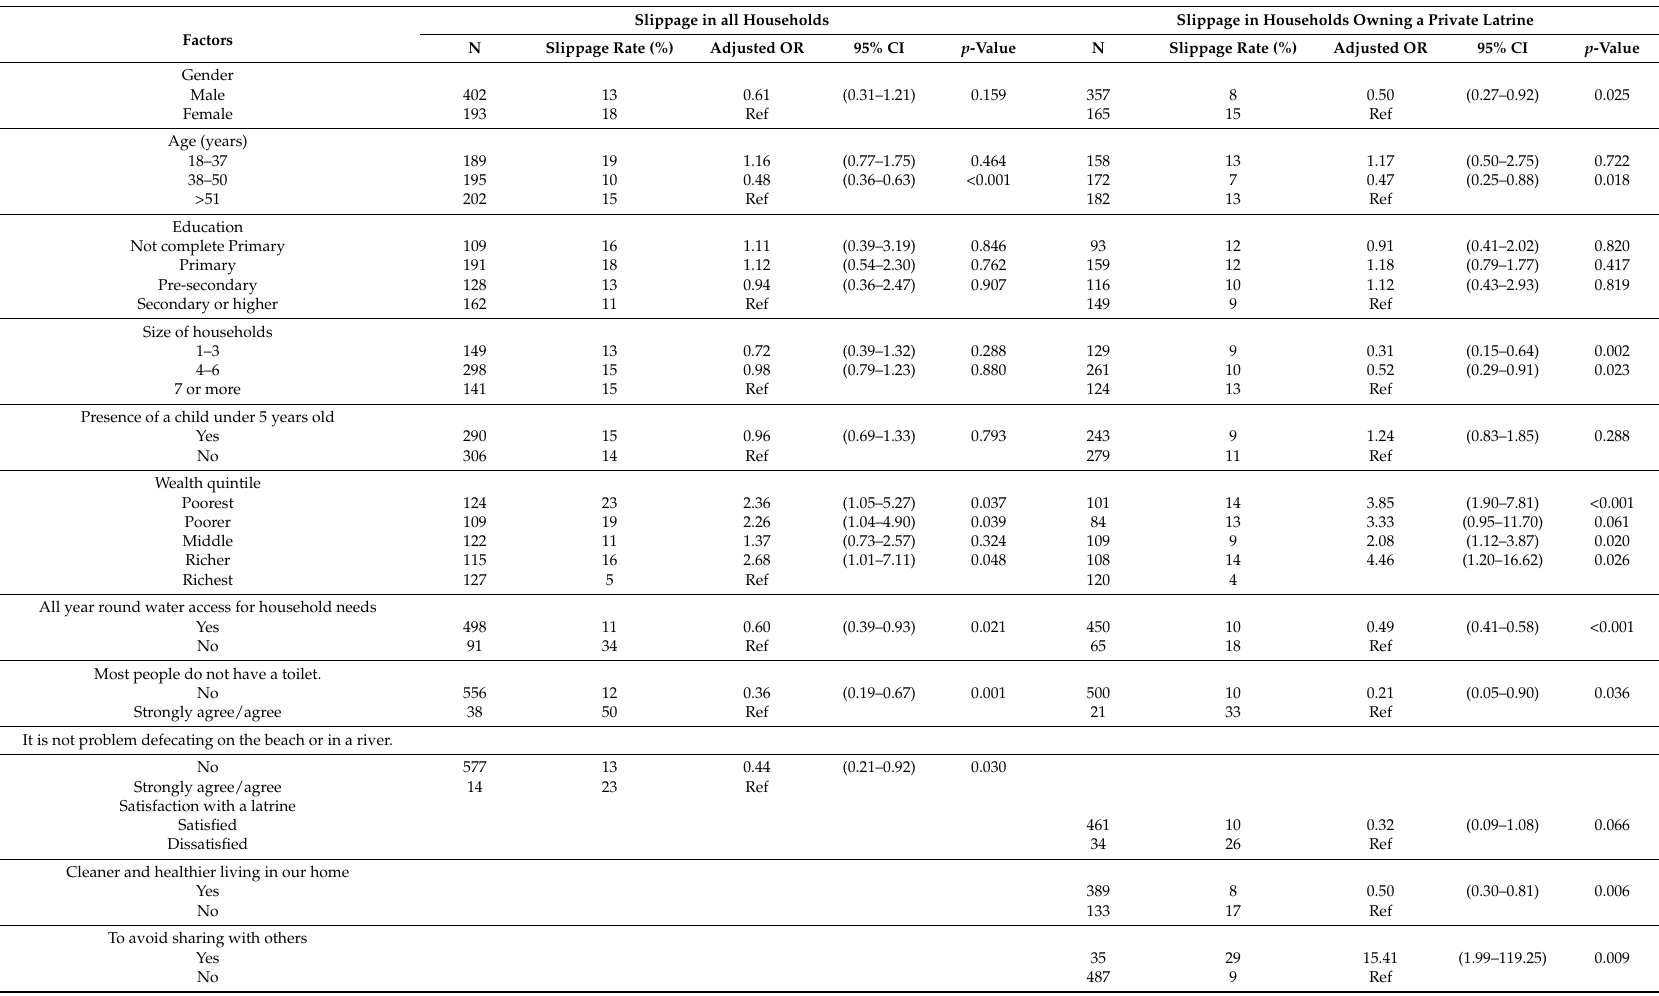
Table 3. Multivariate Logistic Regression Analysis on Factors Associated with (1) Slippage among All Households, and (2) Slippage among Households Owning a Private